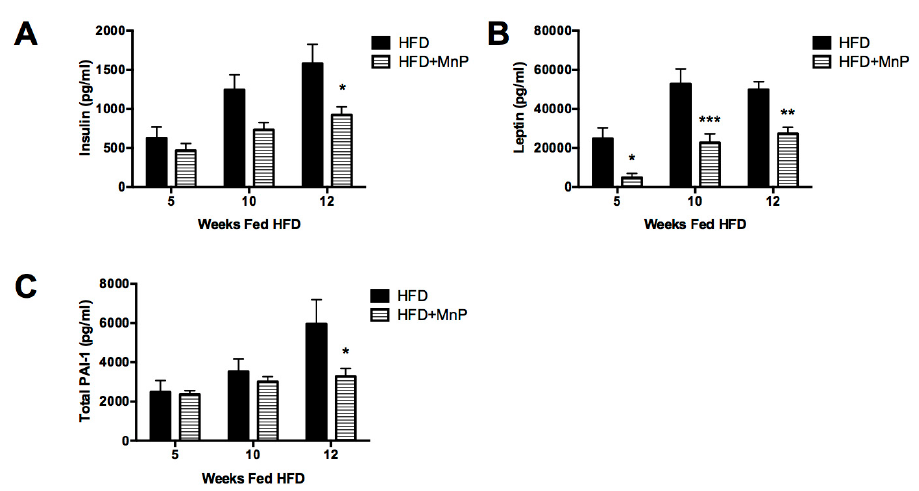
Figure 5. MnP treatment lowered serum adipokines. ( A ) serum insulin; ( B ) serum leptin and ( C ) serum PAI-1 were measured at 5, 10, and 12 weeks of HFD feeding, n = 5 mice per group. Data are displayed as mean ± SEM. Significance was calculated by two-way ANOVA with a Bonferroni post-test of multiple comparisons. * indicates p ≤ 0.05, ** indicates p ≤ 0.01 and *** indicates p ≤ 0.001.